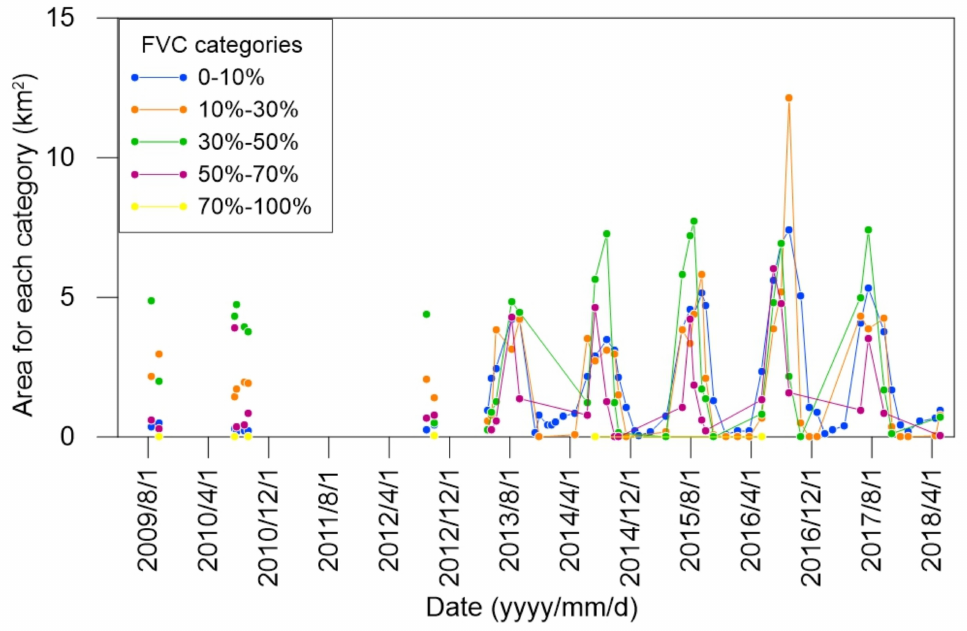
Figure 8. Variations over time of the vegetation coverage for di ff erent fractional vegetation coverage (FVC) categories in Qingtu Lake and its surrounding area within 10 kilometers. (Note: There is a lack of Landsat series satellite data from 2009 to 2013, among which there are only two data sets from August and September in 2009, four data sets from July, August and September in 2010, one data set from July, 2011, and two data sets from August and September in